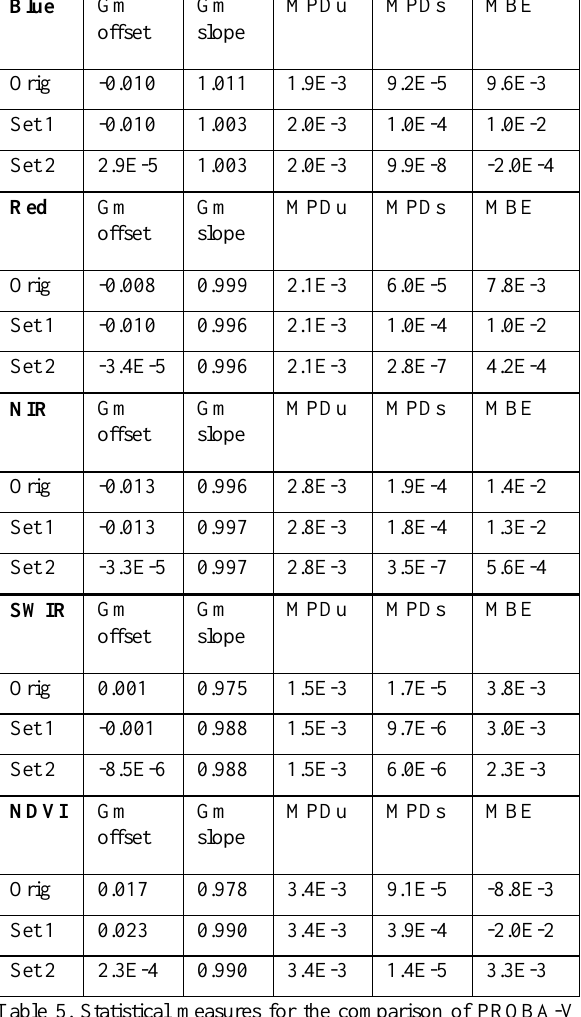
Table 5. Statistical measures for the comparison of PROBA-V (X) and VGT2 (Y) composites for the original PROBA-V data and for 2 sets of spectrally corrected PROBA-V data